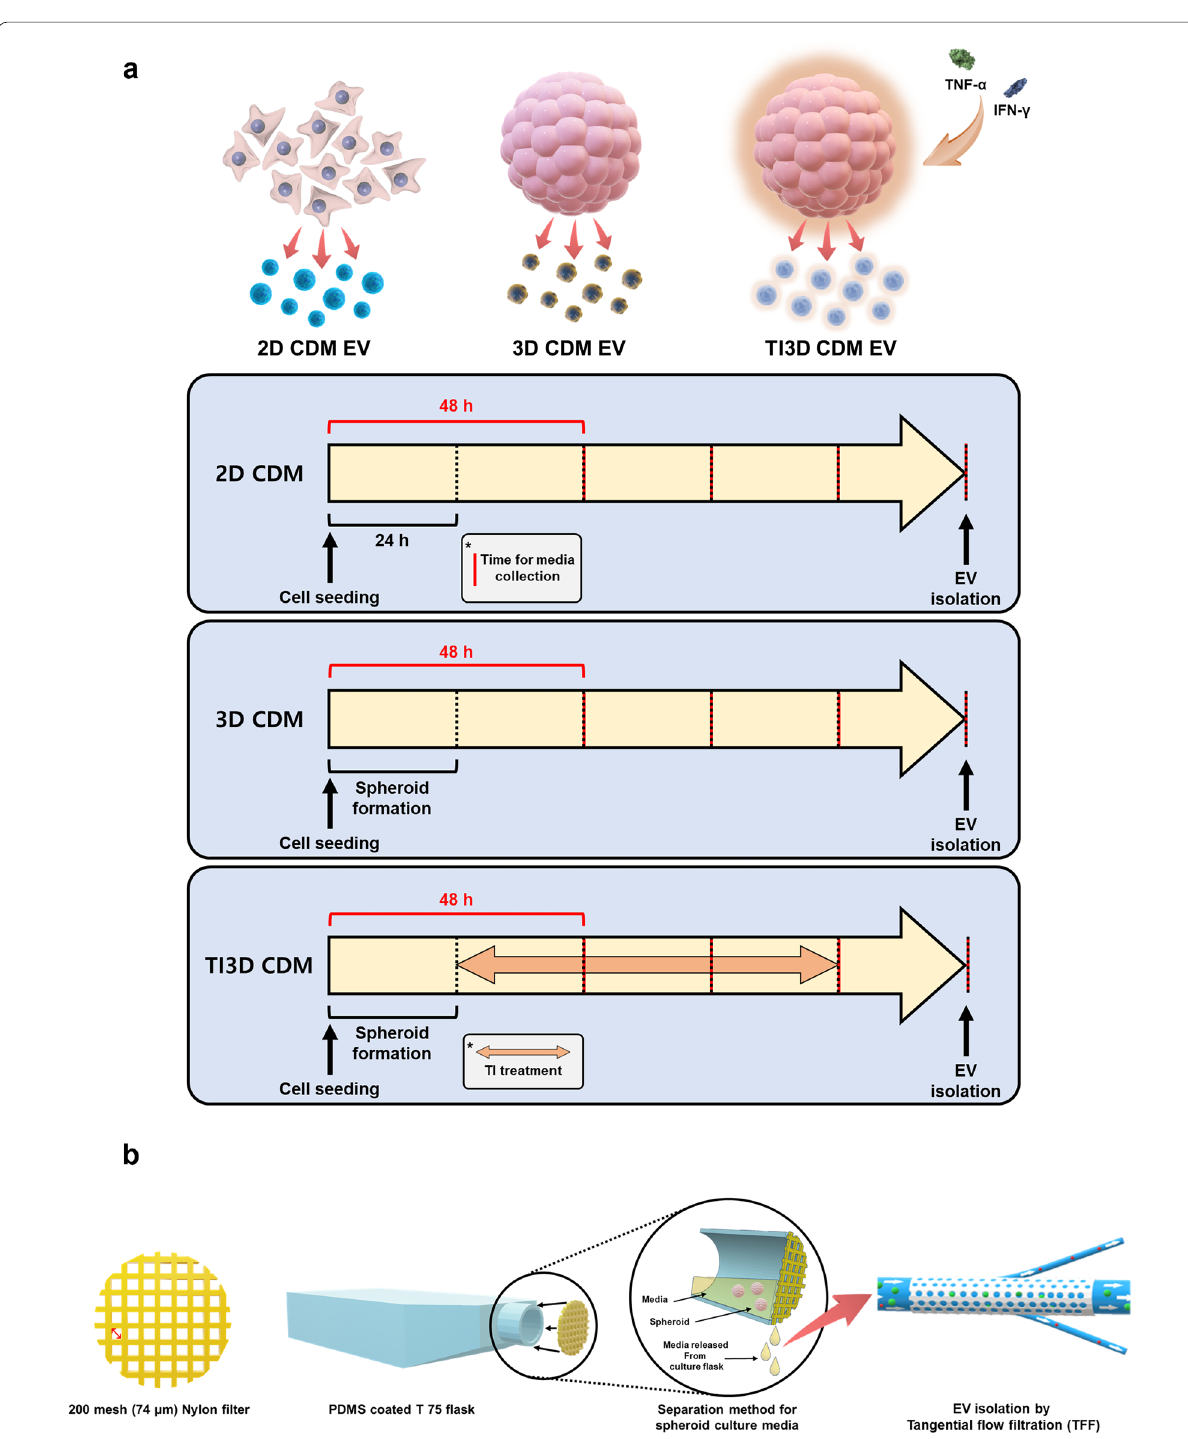
Fig. 1 The schematic representation for human umbilical cord mesenchymal stem cells (hUCMSC)‑derived extracellular vesicles (EVs) with 3D culture and TI priming in chemically defined media (CDM). a Time schedules for cell culture and EV isolation. b A set up for media changeable 3D spheroid culture